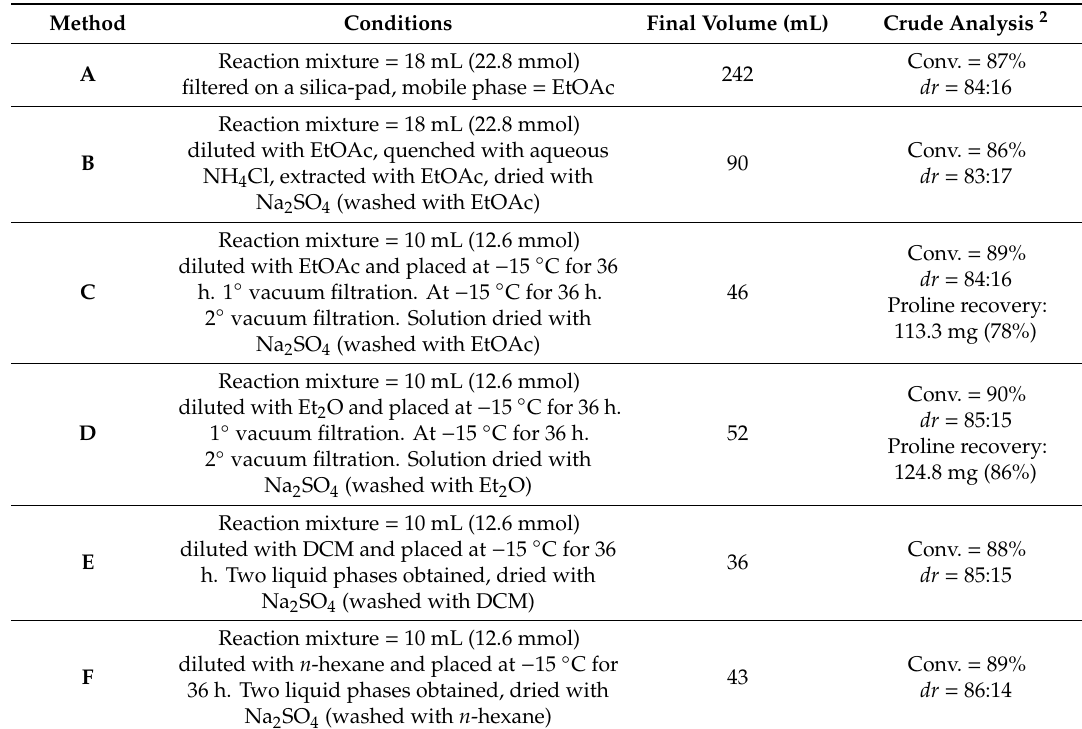
Table 8. Process work-up study 1